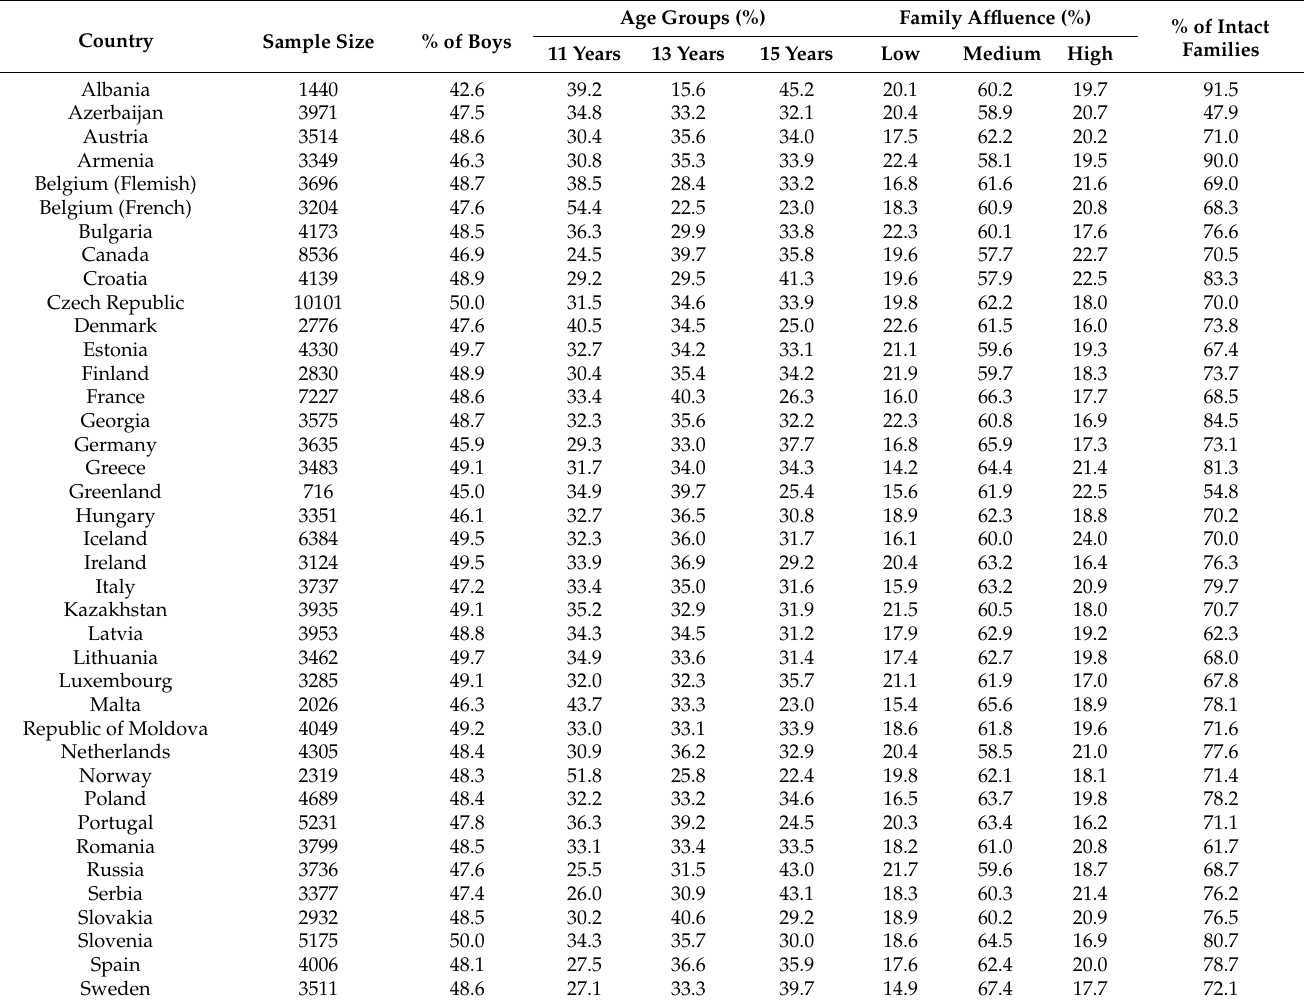
Table 1. Sample size and socio-demographic characteristics of study participants, by countries.